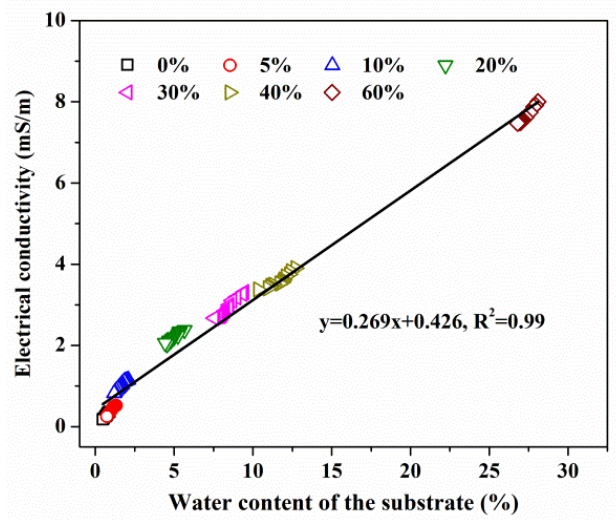
Figure 4. Relationship between the electrical conductivity and water content of wetland substrates with different sediment fractions ( v / v ) (from 0% to 60%).